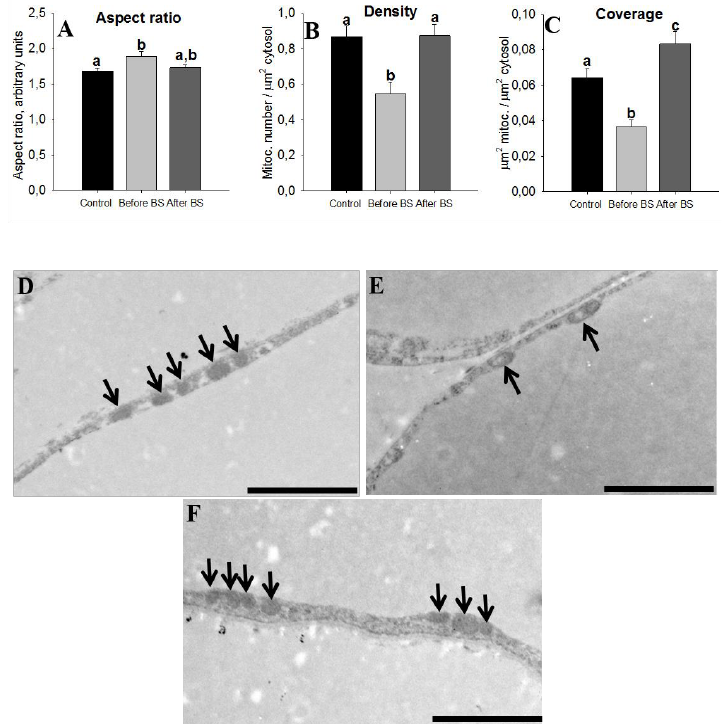
Figure 6. Mitochondrial morphometrics. Characterization of mitochondrial parameters in aSAT of control patients (healthy patients with normal BMI, n = 5), obese patients before bariatric surgery (before BS, n = 4), and obese patients after bariatric surgery and body weight normalization (after BS, n = 5). Values are means ± SEM. Different letters above the bars indicate statistically significant differences, p < 0.05. The aspect ratio is a measure of mitochondrial length (major axis/minor axis) (A) , mitochondria density (B) and coverage (C) were calculated by dividing the number and total area of mitochondria to the cytoplasm area, respectively. Representative electron microscopy images of aSAT sections from control patients (D) , obese patients before bariatric surgery (E) and obese patients after bariatric surgery (F) , respectively. Bars = 2 µm. The arrows point to the mitochondria.